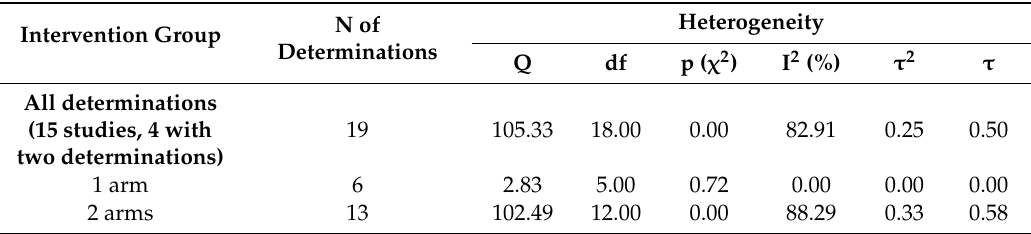
Table 4. Global heterogeneity in the group intervened with active video games, and depending on their design (1 or 2 arms). All measurements and all